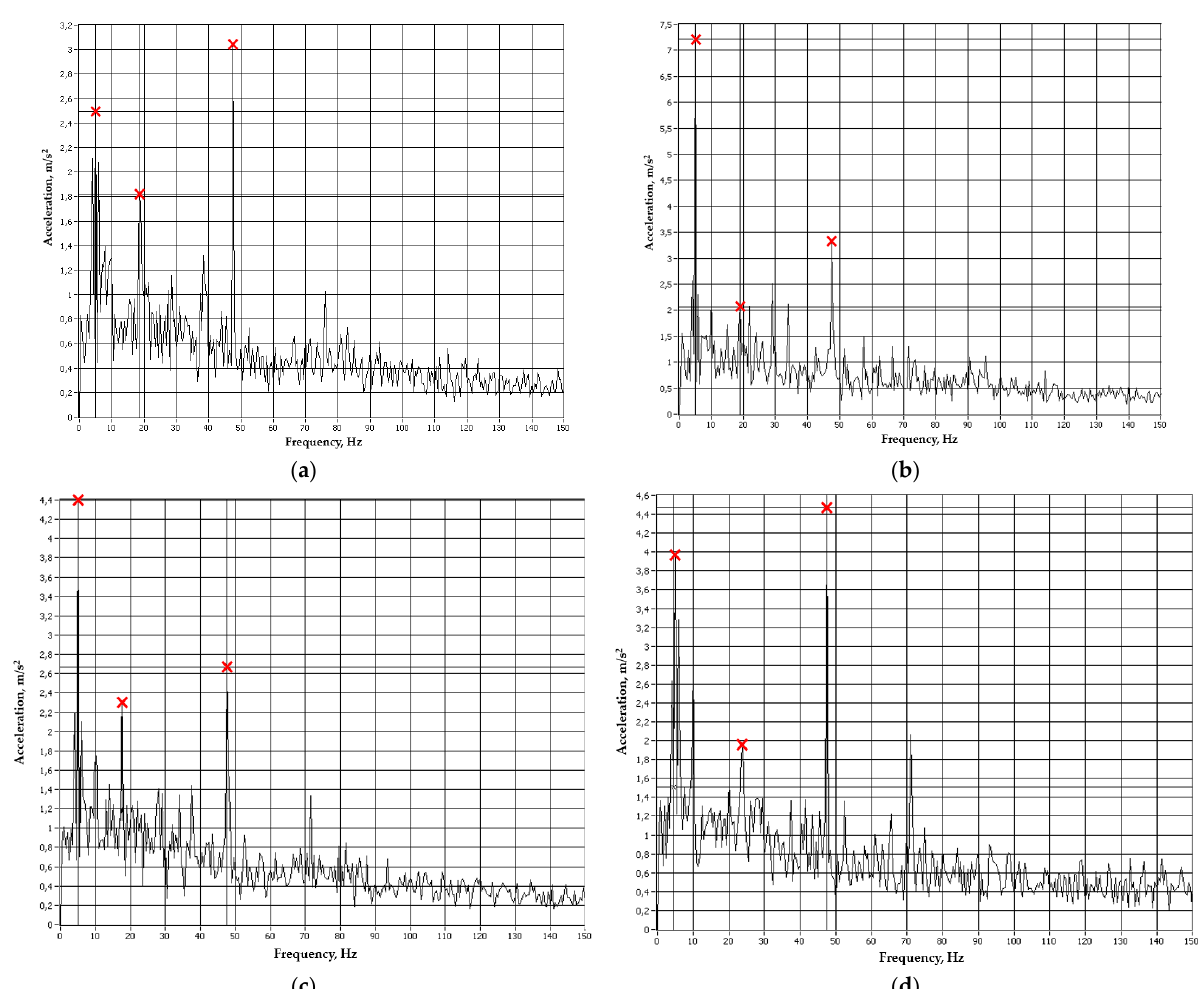
Figure 16. Vibration spectra of faulty bearings: ( a ) damaged outer ring, ( b ) damaged cage, ( c ) complex damage, and ( d ) material fatigue.